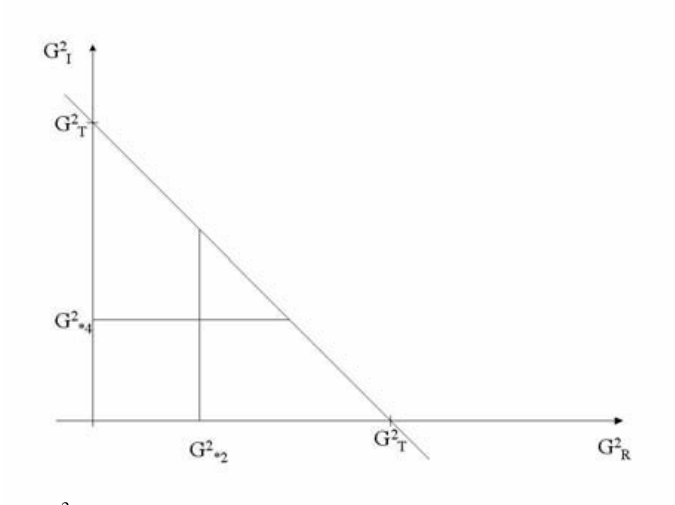
Figura 1 – Domini di G 2